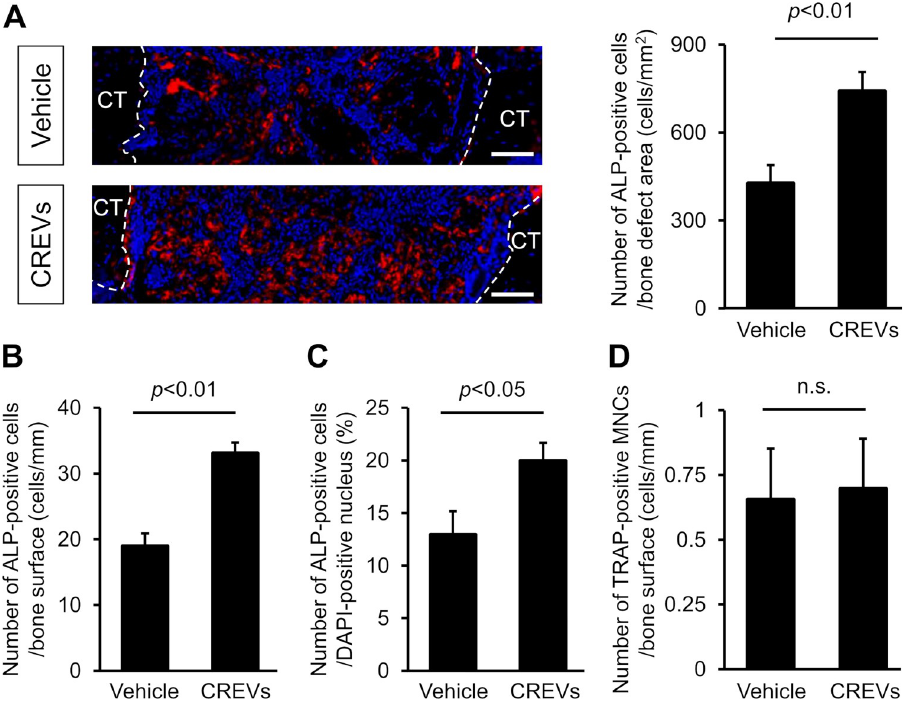
Fig 3. Effects of the local administration of CREVs on the osteogenic marker at damaged sites. Images of ALP- positive cells and the number of ALP-positive cells per area (mm 2 ) (A), bone surface (mm) (B), and the number of DAPI-positive nucleus (C) at the damaged site 7 days after the femoral bone defect. Results are expressed as the means ± SEM of 8 mice per group. Scale bars indicate 100 μ m. The dotted line indicates the boundary with cortical bone. (D) The number of TRAP-positive multinucleated cells (MNCs) per bone surface (mm) at the damaged site 7 days after the femoral bone defect. Results are expressed as the means ± SEM of 6 (Vehicle) or 8 (CREVs) mice per group, respectively. Statistical analyses were performed using the Mann–Whitney U test.